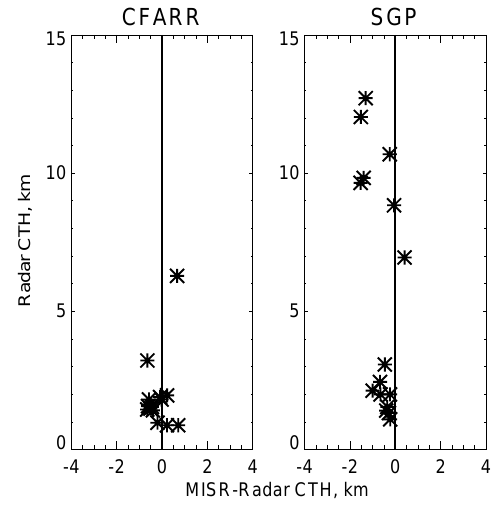
Fig. 5. Radar vs. Difference MISR - Radar cloud-top heights for single level cloud cases selected at CFARR (left) and SGP